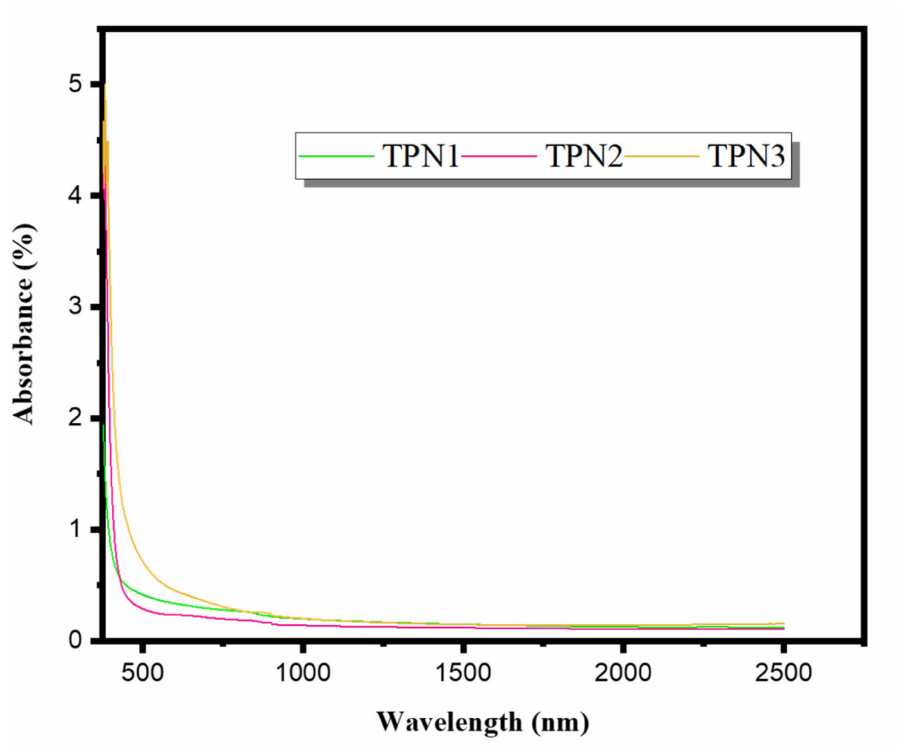
Figure 1. Absorbance spectroscopy for different compositions of TPN.